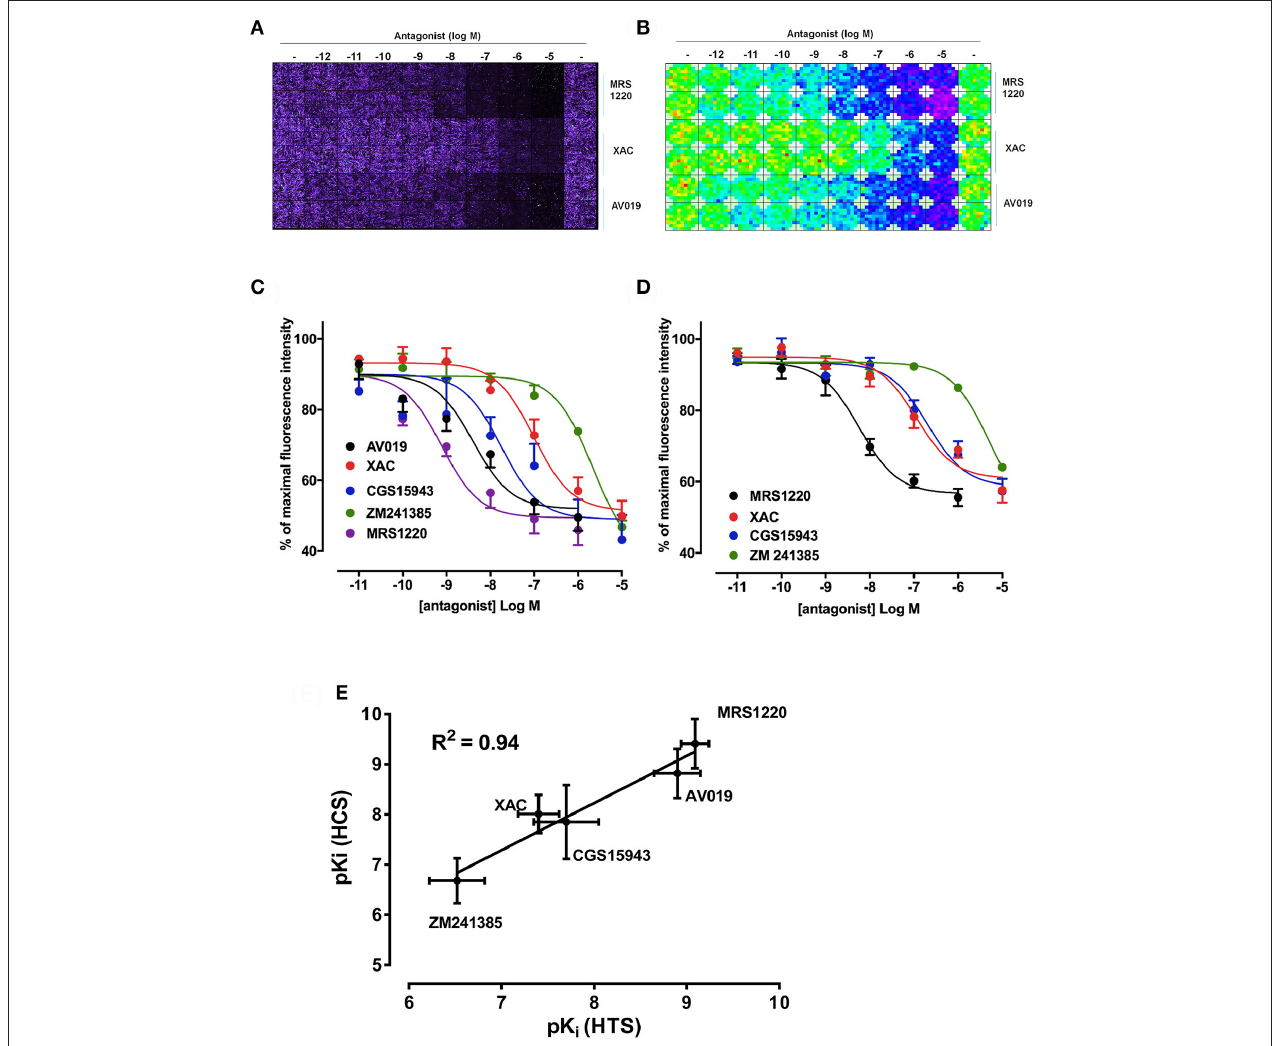
FIGURE 1 | Competition binding at the A 3 AR using fluorescent ligands. CHO cells expressing the A 3 AR were incubated with 25nM CA200645 and increasing concentrations of MRS1220, XAC, or AV019. (A) Four images per well were obtained on the IX Ultra confocal plate reader and resulting images shown as a montage. (B) Montage fluorescence intensity measurement of the same plate obtained using the FS PHERAstar where blue, green, yellow and red pixels represents increasing intensity of fluorescence. (C) Competition curves at the A 3 AR generated from the total fluorescence intensity measured on the PHERAstar FS microplate reader for five adenosine receptor antagonists. (D) CHO A 3 AR cells were incubated with increasing concentrations of antagonist and 5nM AV039 for 1h, 37 ◦ C, washed and fluorescence intensity assessed using the PHERAstar FS. (E) Correlation between pKi values obtained using the IX Ultra (high content screening; HCS) and the PHERAstar FS (high throughput screening; HTS) for the data obtained using CA200645 as fluorescent ligand. Data were normalized to the maximal intensity observed per experiment and each data point represents the mean ± SEM from n number of experiments (See Table 1 ) performed in triplicate.